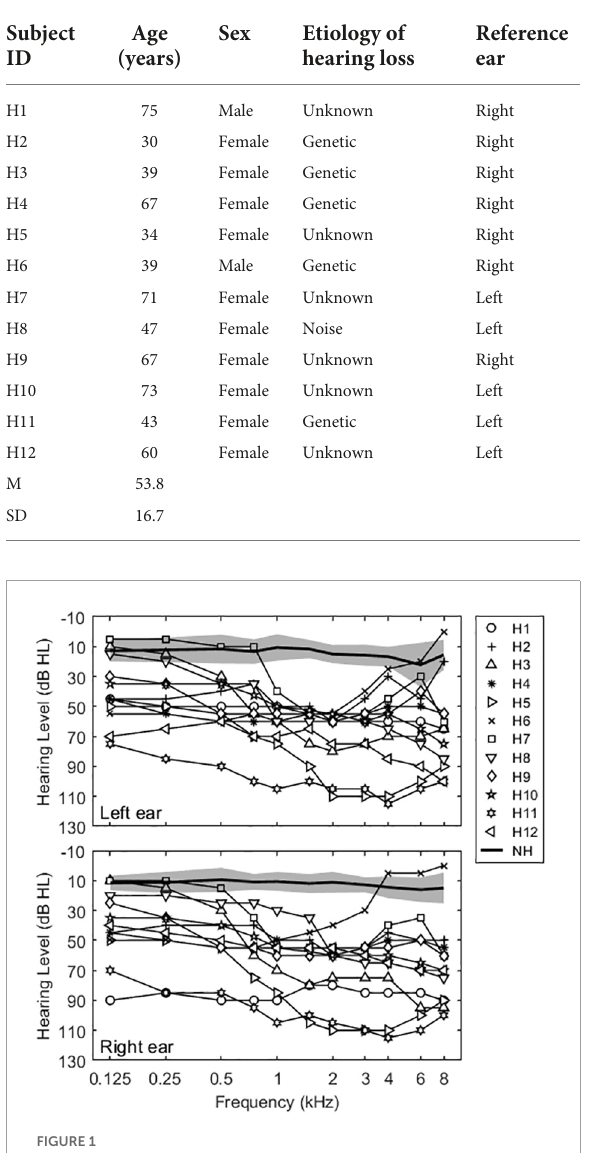
FIGURE1 Unaided audiograms for the NH and bilateral HA subjects in this study. Solid thin lines show individual thresholds for bilateral HA users. Solid thick lines and shaded areas represent averaged thresholds and standard deviations for NH subjects.